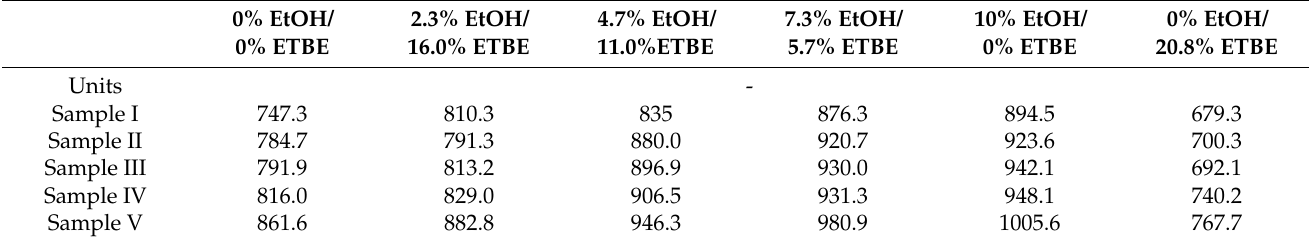
Table 12. VLI of ternary blends base fuels/bio-EtOH/bio-ETBE.